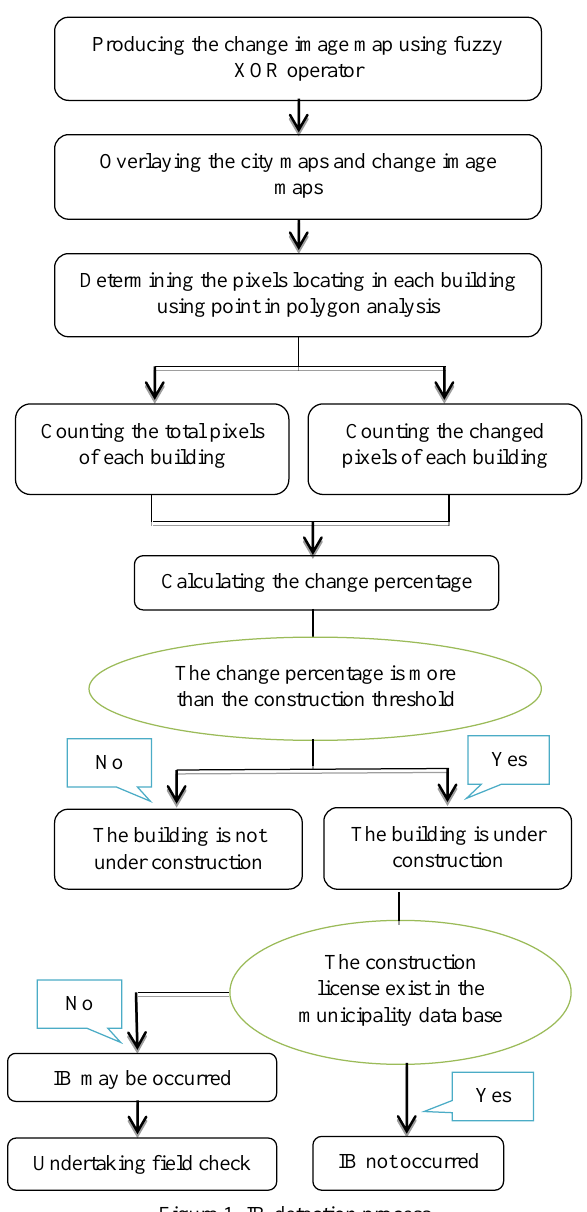
Figure 1. IB detection